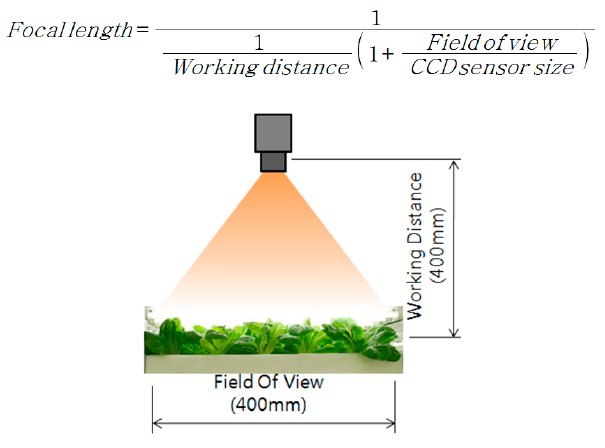
Figure 5. Setting the image acquisition range for selection of lens.